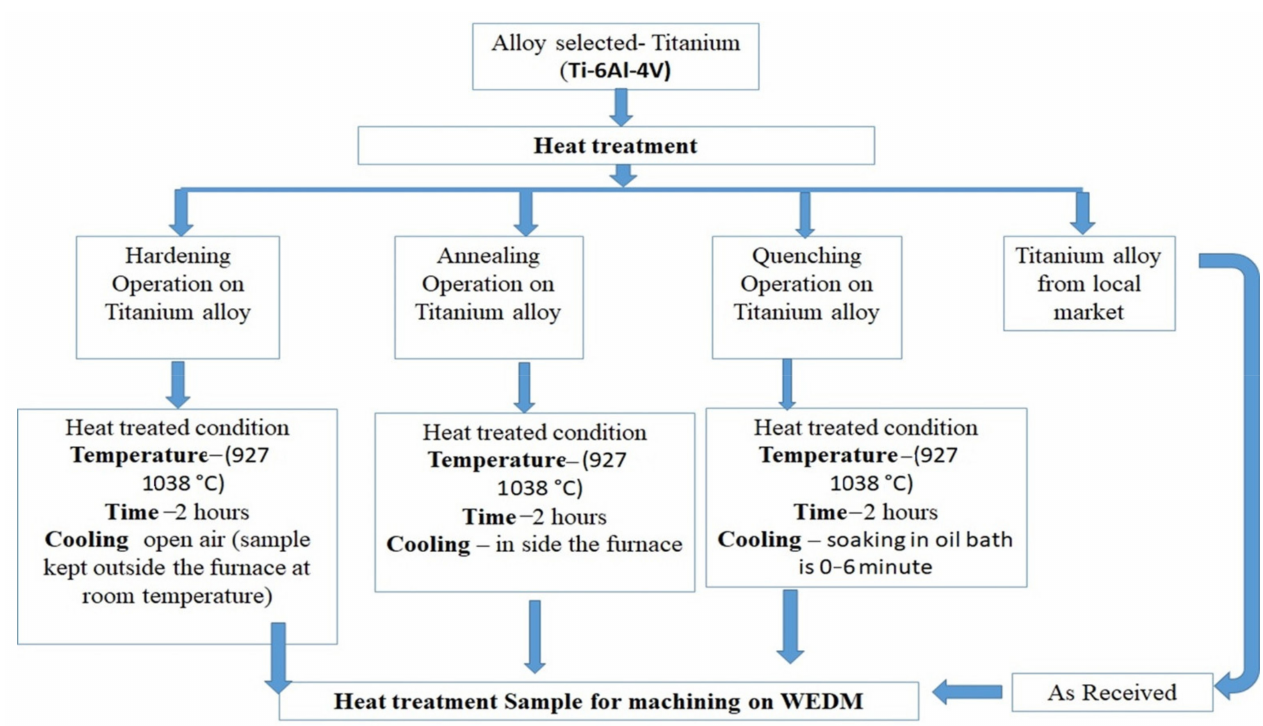
Figure 3. Methodology of the research.